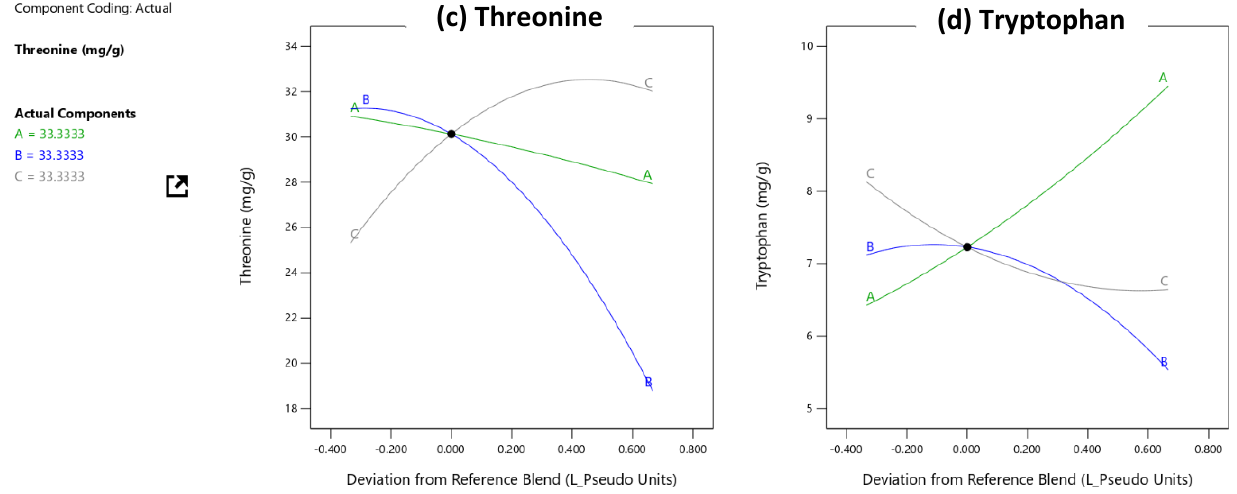
Figure 1. Influence of the raw material (Quinoa, Corn and Lupine) about supply of amino acids, according to the list: ( a ) Lysine; ( b ) Sulfur amino acids (SAA); ( c ) threonine and ( d ) tryptophanen- tonce.